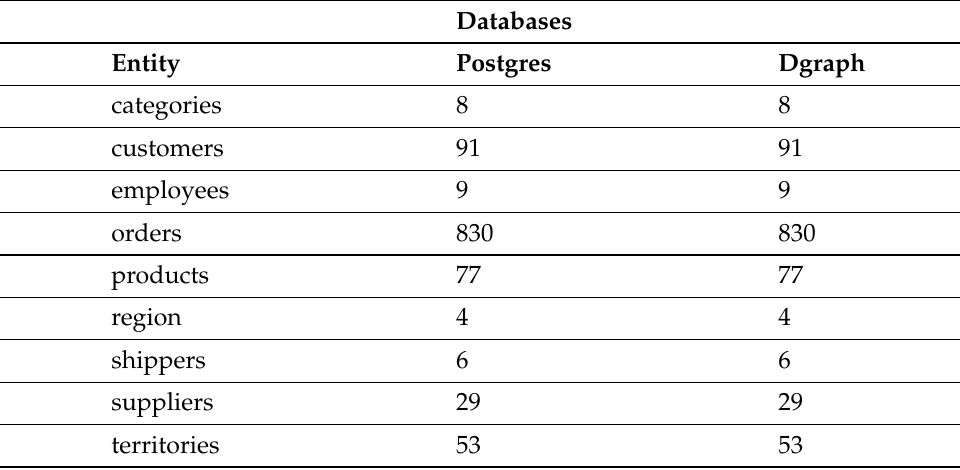
Table 2. Number of migrated elements from Postgres to